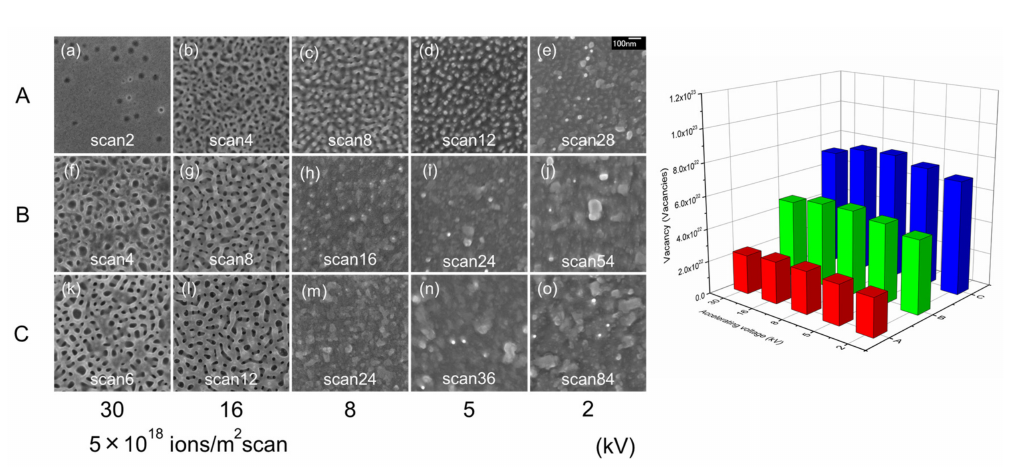
Figure 3. Surface SEM images of InSb irradiated with a Ga + ion beam at room temperature ( left ). The accelerating voltages used were 2, 5, 8, 16, and 30 kV at a scanning dose of 5 × 10 18 ions/m 2 per scan. The total number of vacancies created on InSb was estimated using the ion dose (ions/m 2 ) multiplied by the vacancy count (/ion) as calculated by SRIM simulations, as a function of accelerating voltage ( right ).